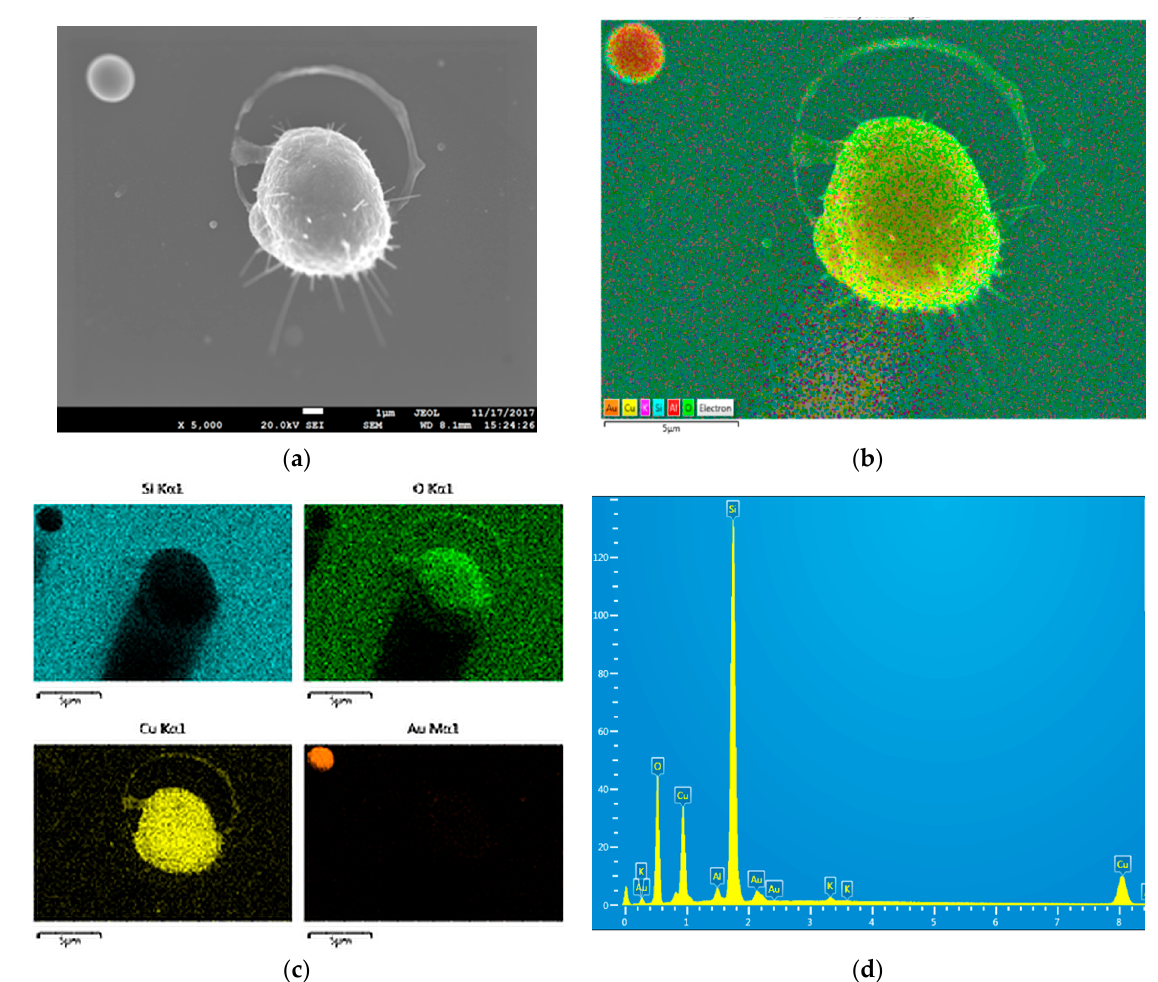
Figure 5. ( a ) SEM picture of a CuO/Au particle of the chemosensor surface for the detection of CO gas, ( b ) SEM/EDS elemental analysis composite image, ( c ) SEM/EDS image maps of the Cu/Au particle, and ( d ) SEM/EDS counts/element analysis spectrum. [Koralli, P.; Petropoulou, G.; Mouzakis, D.E.; Mousdis, G.K.M. Efficient CO sensing by a CuO: Au nanocomposite thin film deposited by PLD on a Pyrex tube. Sens. Actuators A. Phys . 2021, submitted for publication].